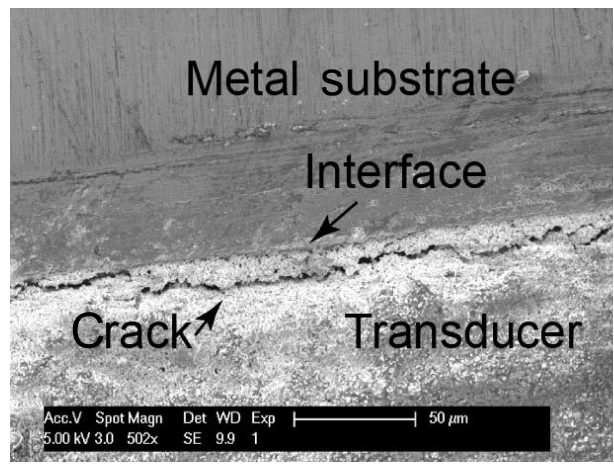
Figure 1. The interface between the ceramic and metal for the 100 ◦ C tube furnace sample.